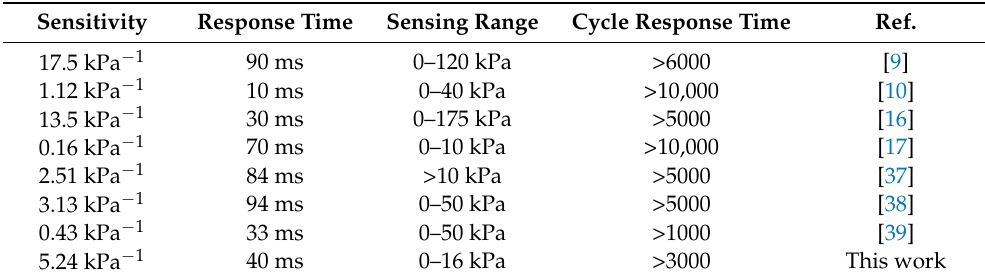
Table 1. Comparison of the proposed capacitive pressure sensor with reported sensor.